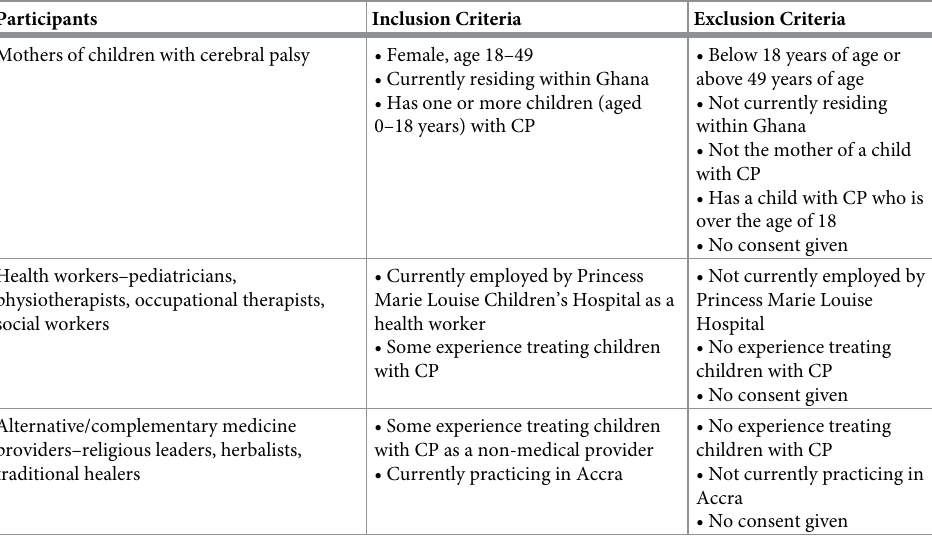
Table 1. Inclusion/Exclusion criteria for